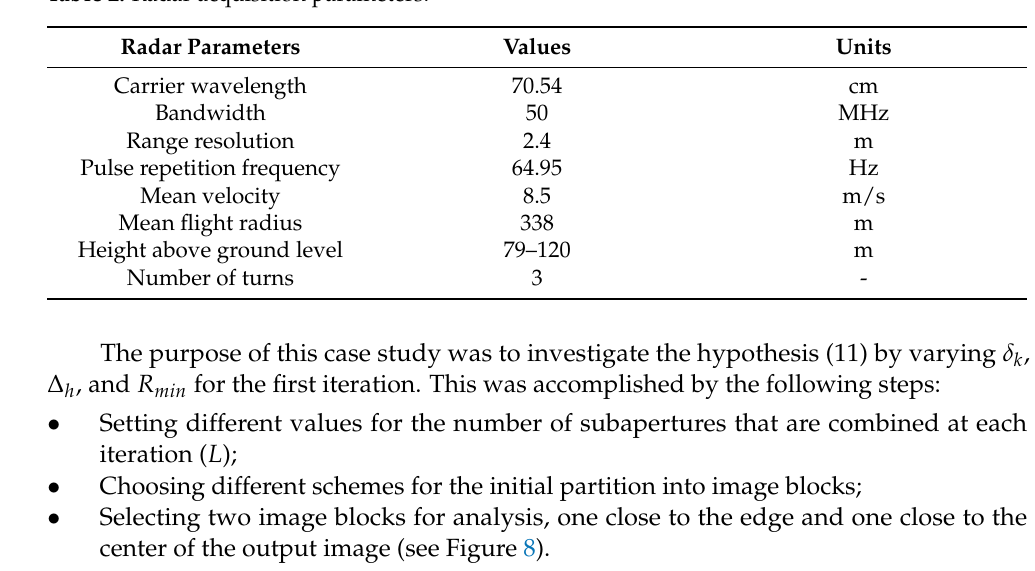
Figure 7. Google Earth image of the spiral flight path over the imaged area. Table 2. Radar acquisition parameters.